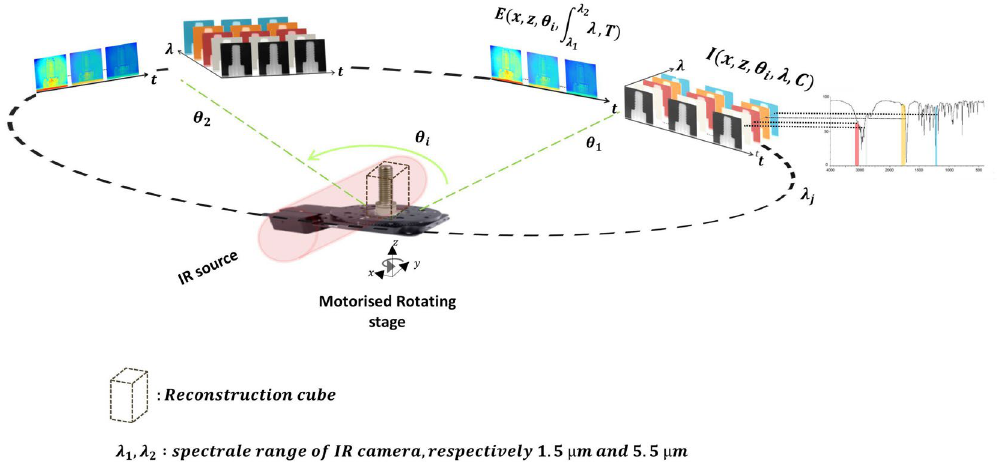
Figure 2. Scheme of the 3DITI measurement principle. (Created with Powerpoint 2013, www.micro